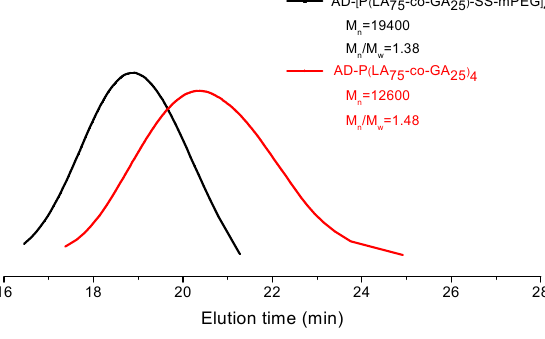
Figure 2. GPC of polymer 3 and AD-P(LA 75 -co-GA 25 ) 4 .